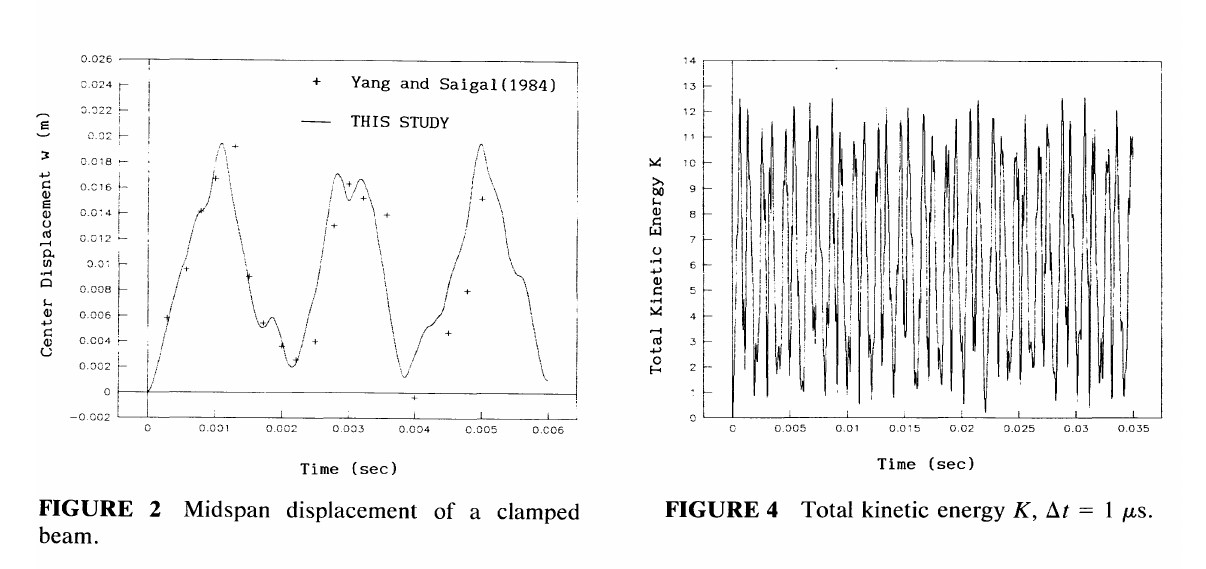
FIGURE 4 Total kinetic energy K, M = I